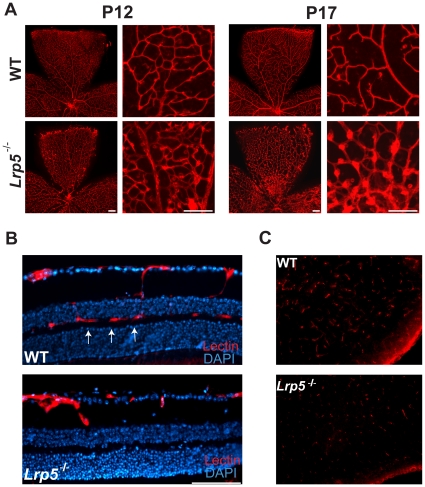
Abnormal vascular development in the inner and outer retina and forebrain of Lrp5 null mice.(A) Retinal whole mounts of WT and Lrp5 null mice stained for endothelial cells with isolectin B4-594 at P12 and 17. Enlarged images highlight the abnormal vessel growth in the Lrp5 null retina. (B) Retinal cross sections from P30 WT and Lrp5 null mice stained for endothelial cells with isolectin B4-594 (red) and cell nuclei with DAPI (blue). Arrows indicate deep layers of retinal vasculature which is present in WT retina but absent in Lrp5 null retina. (C) Cross sections of the forebrain from P8 WT and Lrp5 null mice with endothelial cells stained with isolectin B4-594. Scale bar: 100 µm.